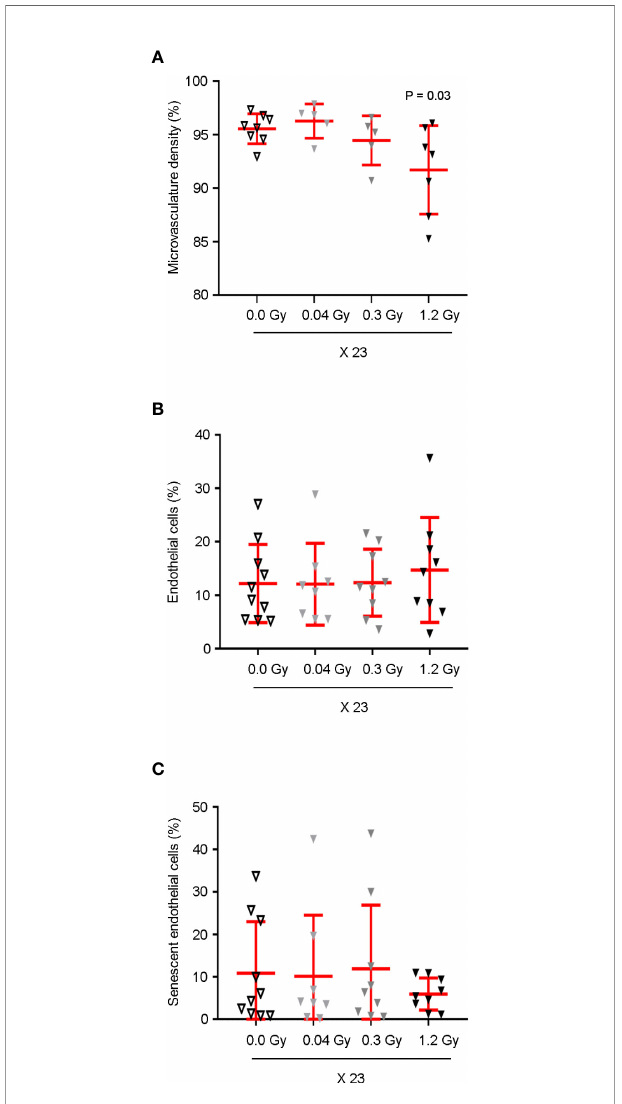
FIGURE 3 | Cardiac microvasculature density is signi fi cantly decreased by the cumulative dose of 27.6 Gy. (A) Microvascular density in the cardiac apex of rats, sham-irradiated (n = 8) or irradiated with 23 daily fractions of 0.04 (n = 5), 0.3 (n = 5), or 1.2 Gy (n = 7), was evaluated by SEM, 12 months after IR exposure. Quantitative analysis of microvascular density is shown as a percentage of average capillary coverage relative to several successive ×100x magni fi cation fi elds, demonstrating a signi fi cant decrease by the 1.2 Gy daily dose. One-way ANOVA combined with Bonferroni correction was used for statistical analysis. (B, C) Seven months after the end of IR exposure, (B) cardiac ECs were analyzed by fl ow cytometry based on cell percentage, in relation to total live single cells. (C) Cell senescence was assessed as the percentage of C12FDG positive ECs. (B, C) No signi fi cant differences were observed between groups n = 10 (0.0 Gy), n = 8 (0.04 Gy), n = 9 (0.3 Gy), and n = 9 (1.2 Gy). Kruskal – Wallis test with Dunn ’ s correction was used for statistical analysis. (A – C) Individual data and mean ± SD (in red) are shown. Signi fi cant P- values are displayed. EC, endothelial